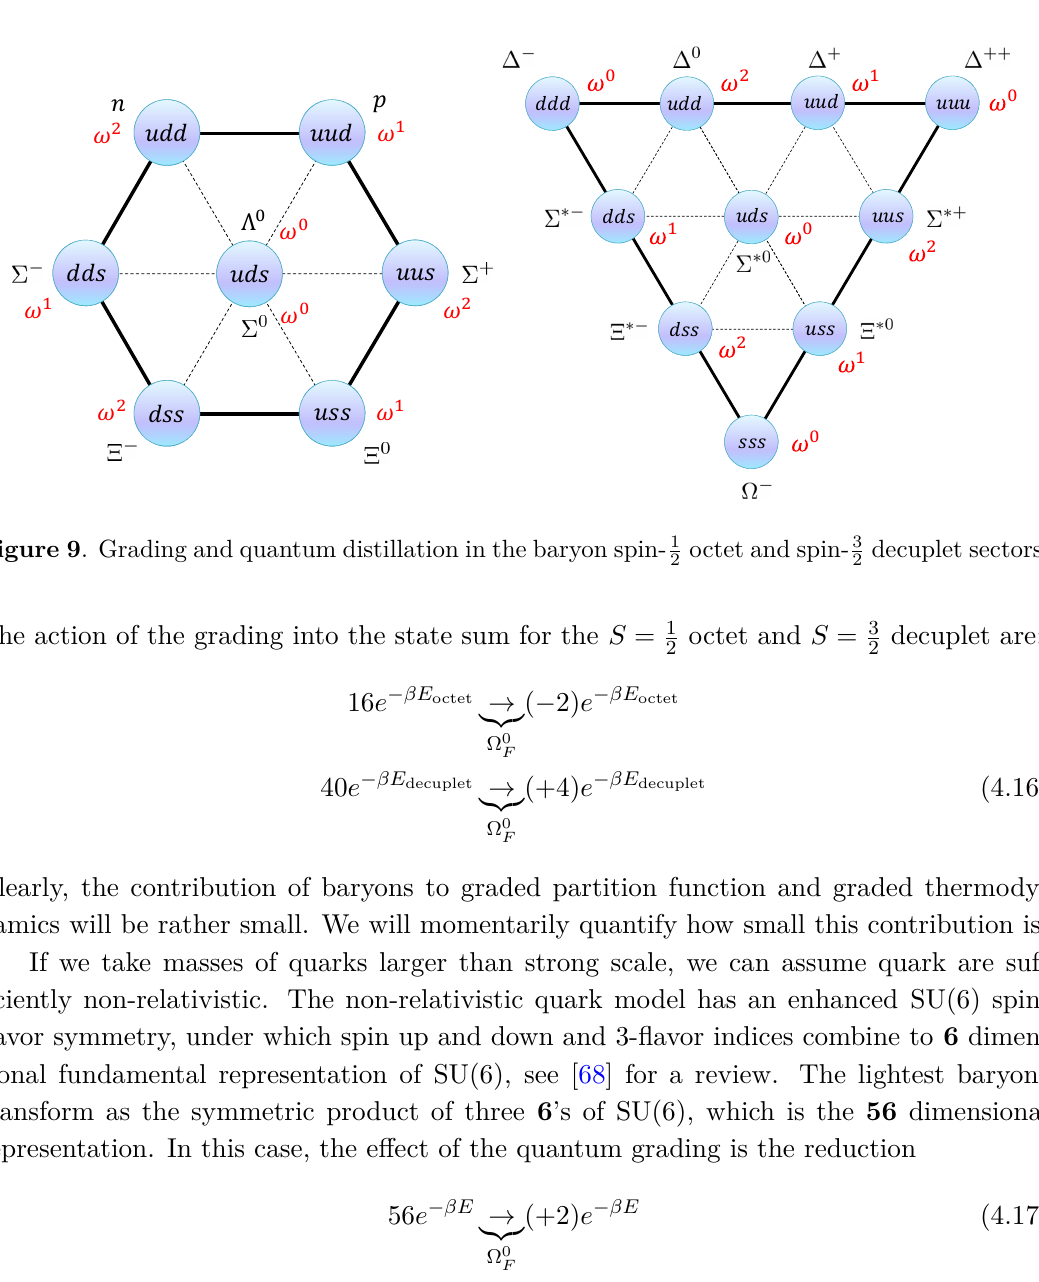
octet and spin- 3 decuplet sectors. 2 2